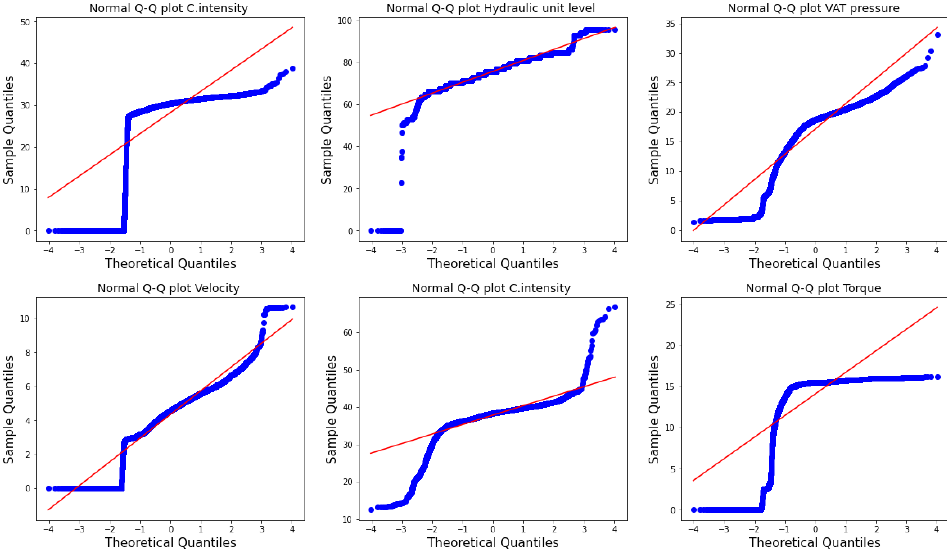
Figure 4. Q–Q plots of the sensor values before data cleaning treatment being